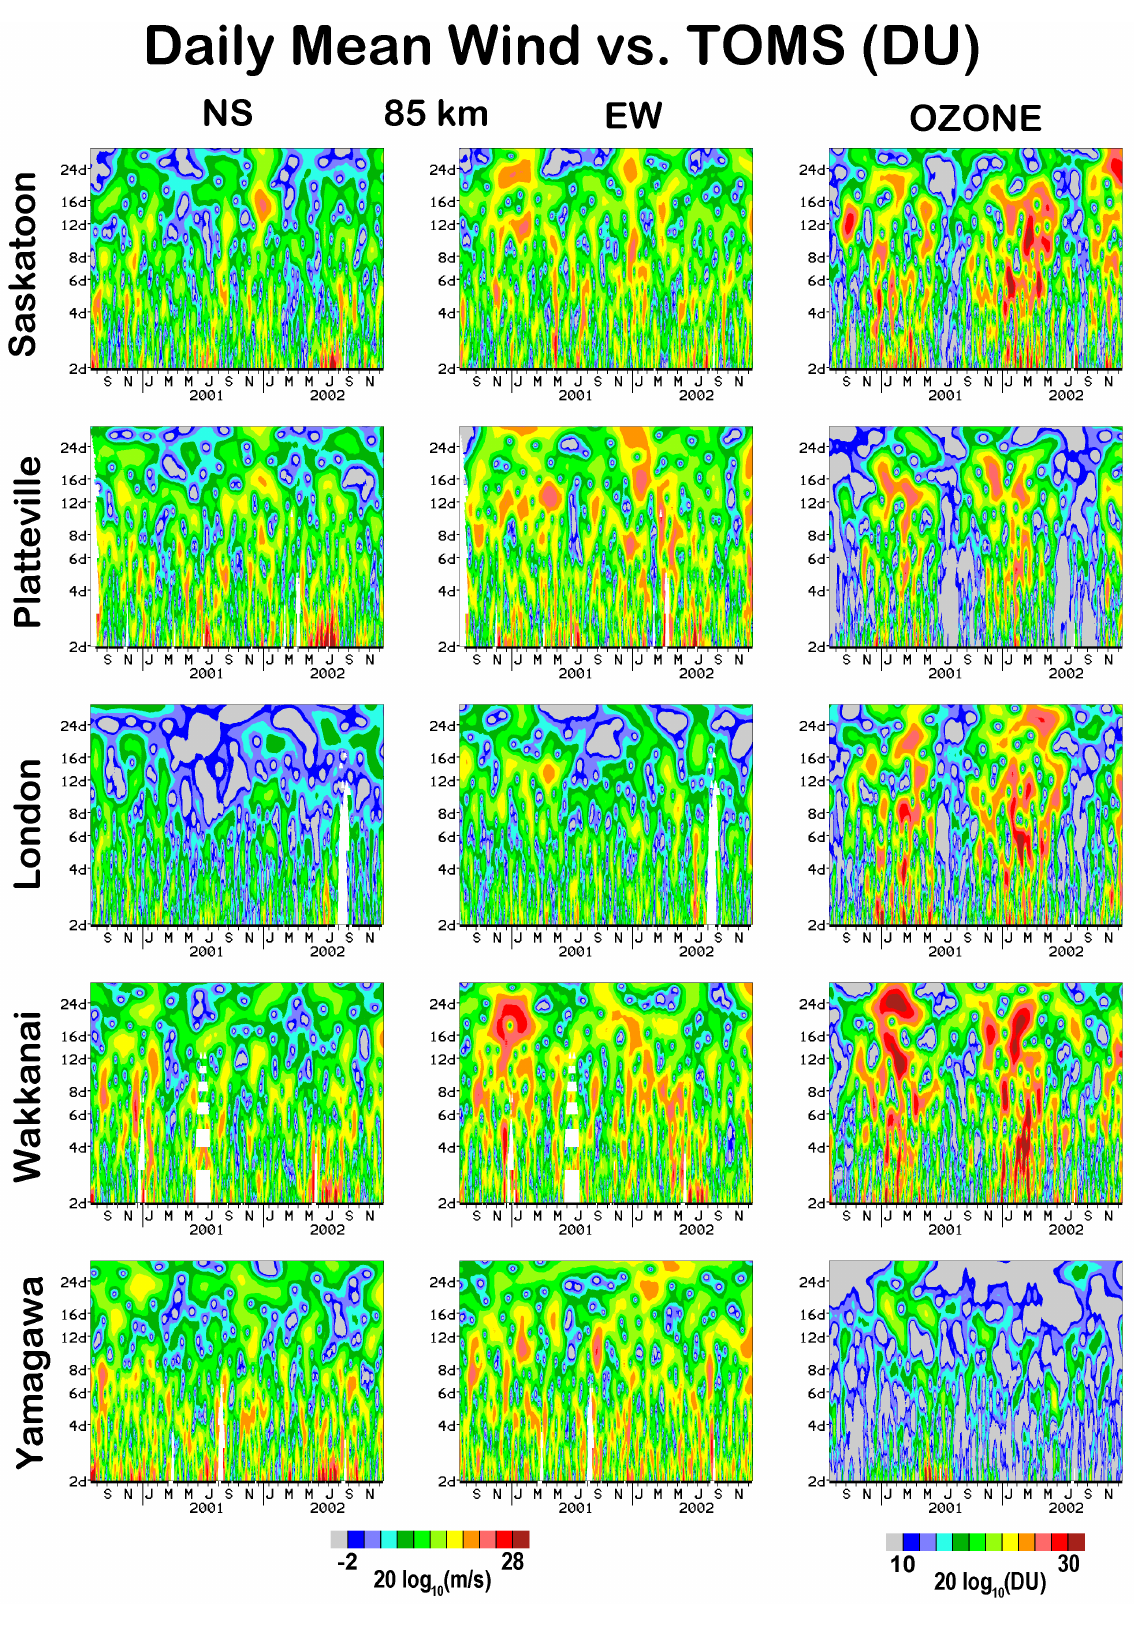
Fig. 2. Wavelet spectral plots for the 85km daily mean winds (zonal EW, meridional NS) and the ozone (DU) values of TOMS for the radar locations of the CUJO